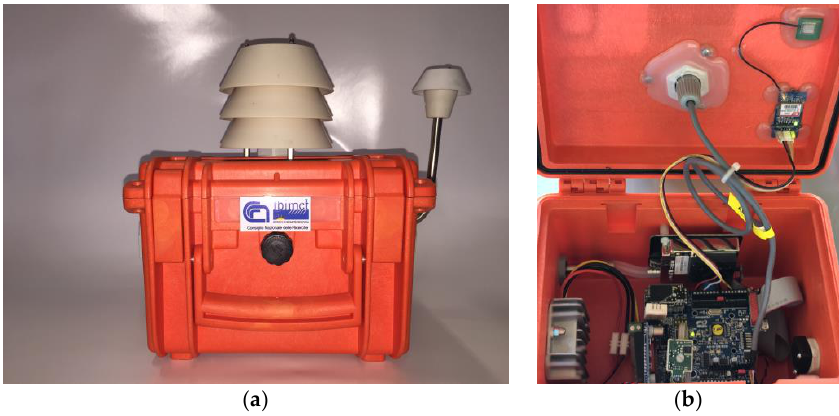
Figure 1. Pictures of the AIRQino monitoring station: ( a ) closed; ( b ) open.